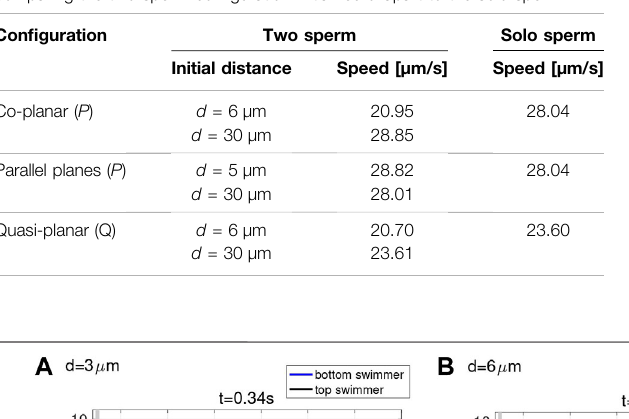
Frontiers in Physics |